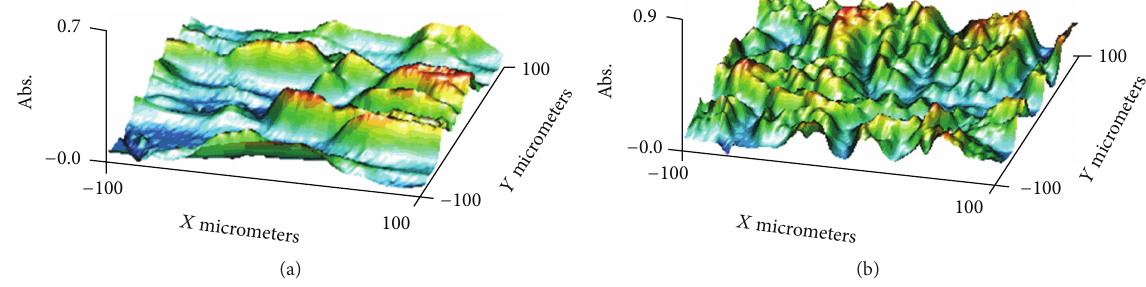
Figure 7: Intensity distribution 3D-maps of synchrotron FTIR microspectroscopy at 1637.8 cm −1 and mapping for the fracture surface of UHMWPE/R-PA6/HDPE-g-MAH blends with different R-PA6 compositions: (a) 40 wt% and (b) 44wt%.